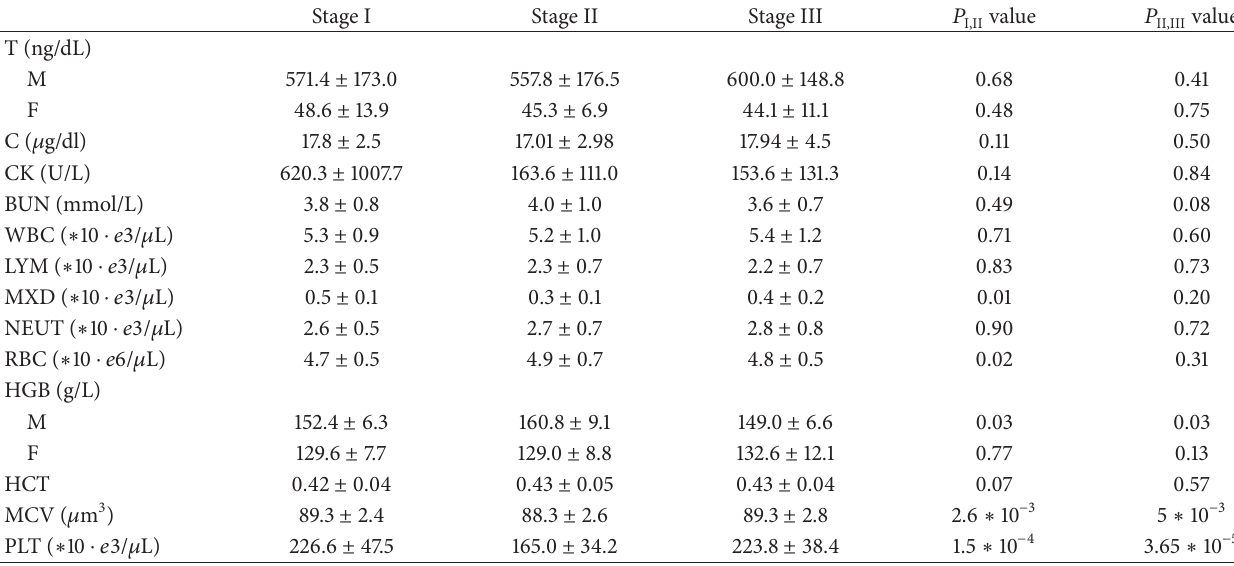
Table 1: Clinical indicators and blood cell levels in different stages.